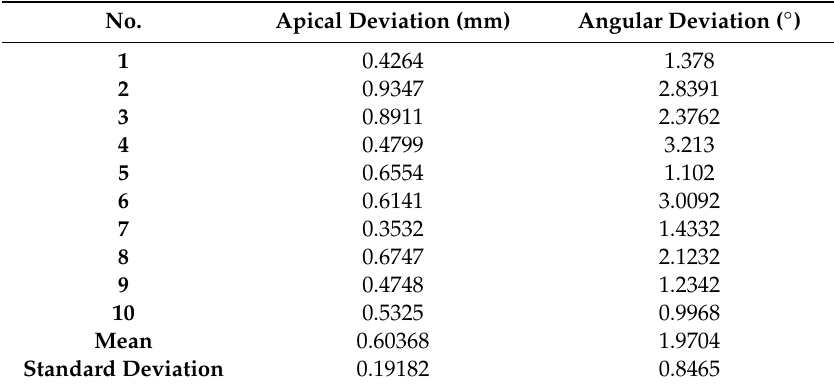
Table 1. Apical and angular deviations between the planned implant fixture and the placed implant fixture of the surgical guides fabricated with the Deltanine software.